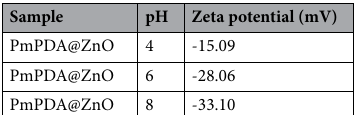
Table 1. Zeta potential values of PmPDA@ZnO at room temperature.